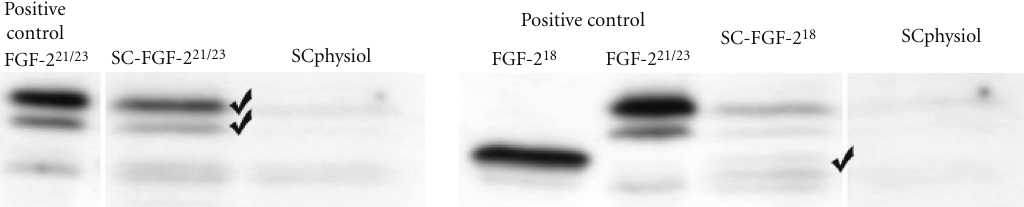
Figure 2: Western Blot analysis of Schwann cell populations prior to transplantation: nontransfected SCs, SCphysiol, show less amount of FGF-2 isoforms (18kD, 21kD, and 23kD) as SCs genetically modified to overexpress FGF-2-18kD, SC- FGF-2 18 , or FGF-2-21/23kD, SC- FGF- 2 21 / 23 . As positive controls served cell lysates from FGF-2 isoform overexpressing PC12 cells.